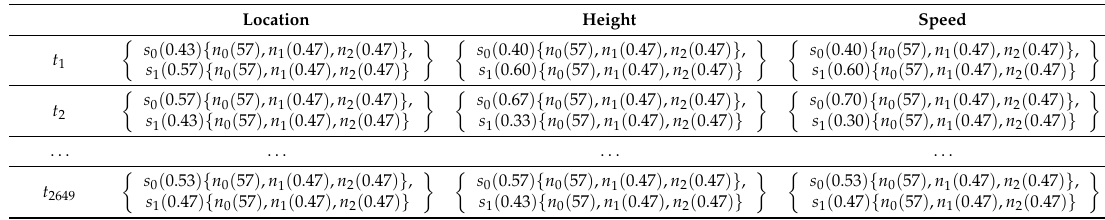
Table 6. Part of the collective evaluation matrix.